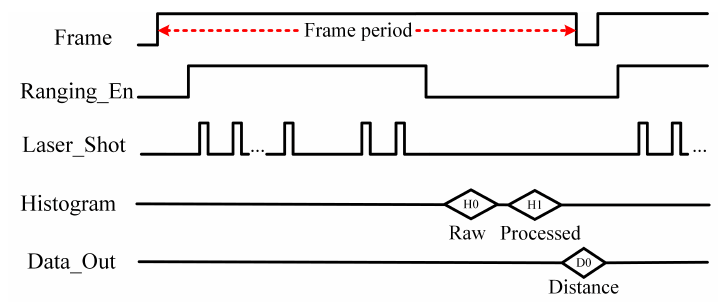
Figure 11. Timing diagrams of the proposed ranging